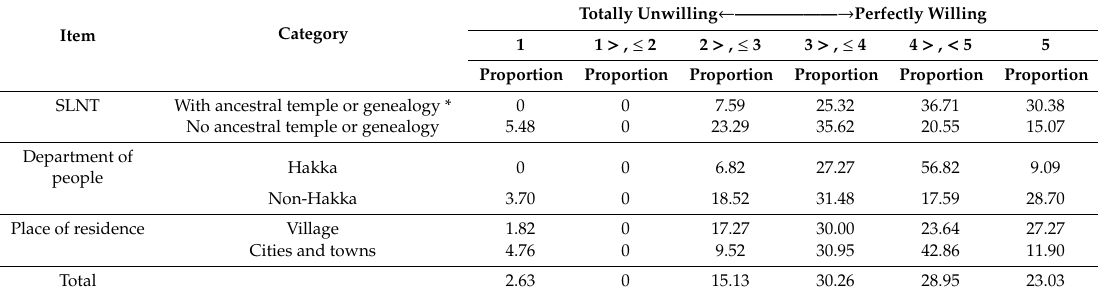
Table 2. Households’ willingness to participate in the provision of small-scale irrigation infrastructure (WPPSI) range